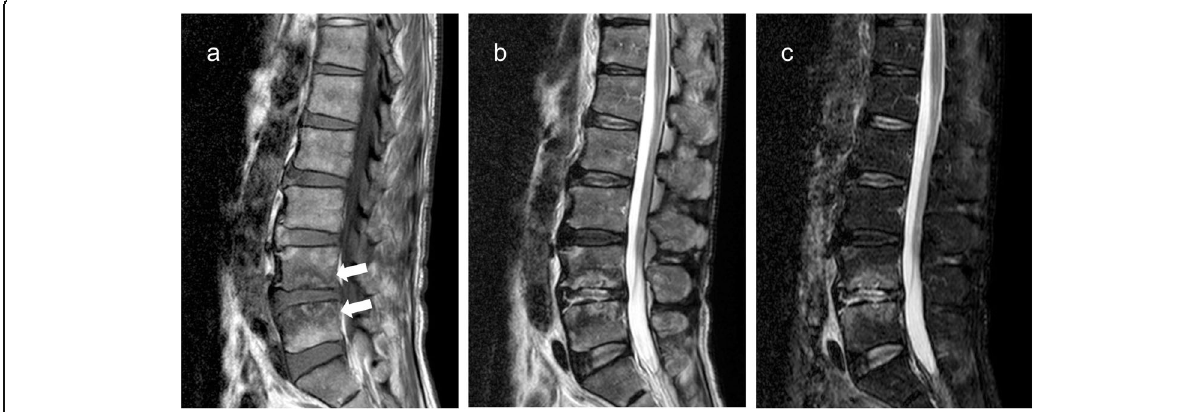
Fig. 2 Magnetic resonance images. T1-weighted image ( a ), T2-weighted image ( b ), and STIR image ( c ) revealed pathological changes in the L4 and L5. The signal intensity in the diseased area was low on the T1-weighted image ( a , arrowheads) and high on the T2-weighted and STIR images ( b , c